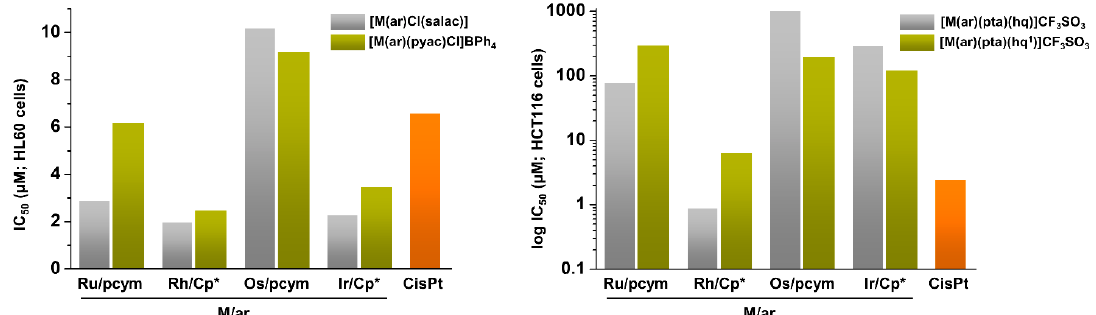
Figure 11. Comparison of in vitro antiproliferative activity of complexes [M(ar)Cl(salac)] and [M(ar)(pyac)Cl]BPh 4 in the HL60 human promyelocytic leukaemia cell line (left), and of complexes [M( η 5 -Cp*)(pta)(hq)]CF 3 SO 3 and [Rh( η 5 -Cp*)(pta)(hq 1 )]CF 3 SO 3 against the HCT116 colorectal carcinoma cell line. Hsalac = acridine-containing salicylal- dimine ligand, pyac = acridine-containing 2-pyridylimine ligand; Hhq = 8-hydroxyquinoline, Hhq 1 = 5-chloro-7-iodo-8-hydroxyquinoline, pta = 1,3,5-triaza-7-phosphaadamantane, ar = η -coordinated arene/arenyl ligand (HCp* = pentamethylcyclopentadiene, pcym = p -cymene), CisPt = cisplatin.